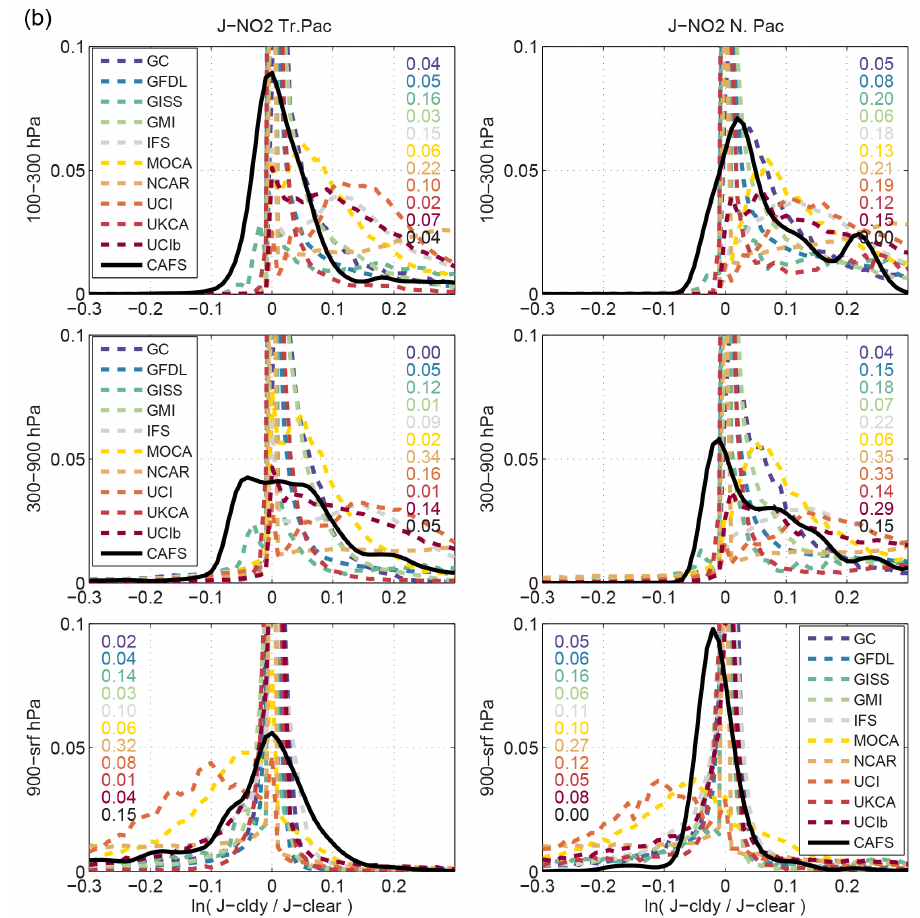
Figure 4. (a) Probability distribution of the natural log of the ratio of cloudy–clear J -O1D values (rlnJ) from 10 models and from CAFS during ATom-1. The columns correspond to the two geographic blocks (tropical Pacific, 20 ◦ S–20 ◦ N × 160–240 ◦ E, and North Pacific, 20–50 ◦ N × 170–225 ◦ E). The rows are the three pressure layers (100–300, 300–900, 900–surfacehPa). All histograms sum to 1, but for many models the peak values about rlnJ = 0, corresponding to cloud-free skies, are truncated. Where a significant fraction of events does not fit within the ± 0 . 3 range – on the high side for 100–900hPa and low side for 900–surfacehPa – the column of numbers, placed on the appropriate side and color coded to the legend, gives the fraction of occurrences outside the range. (b) Probability distribution of the natural log of the ratio of cloudy–clear J -NO2 values (rlnJ) from 10 models and from CAFS during ATom-1. In general, J -NO2 is more responsive to clouds than J -O1D